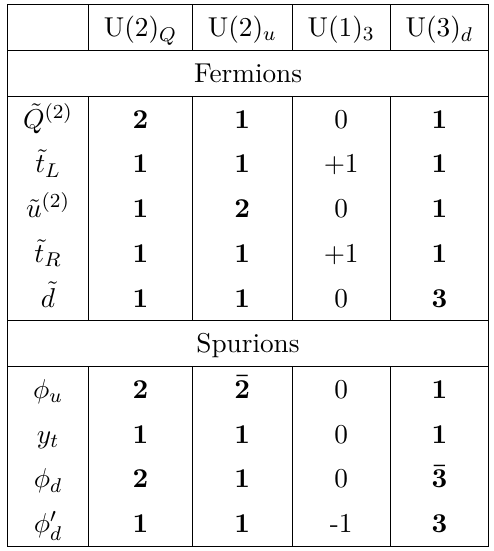
Table 4 . Field representations in the non-linearly realised